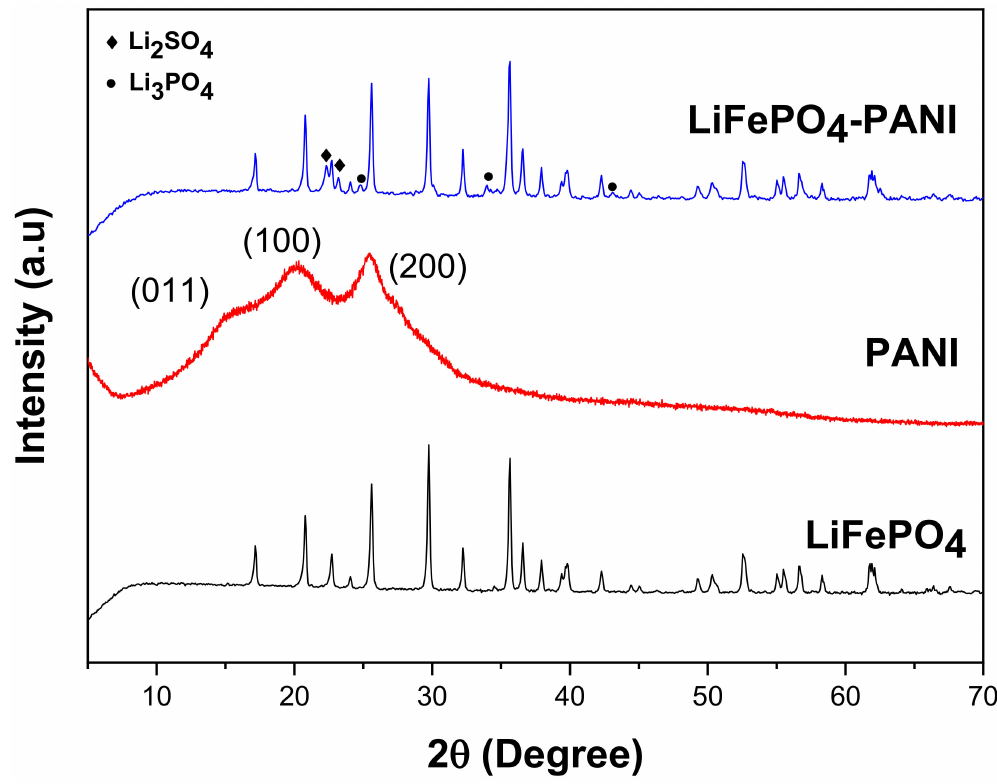
Figure 5. Di ff raction patterns of the LiFePO 4 , PANI and LiFePO 4 –PANI